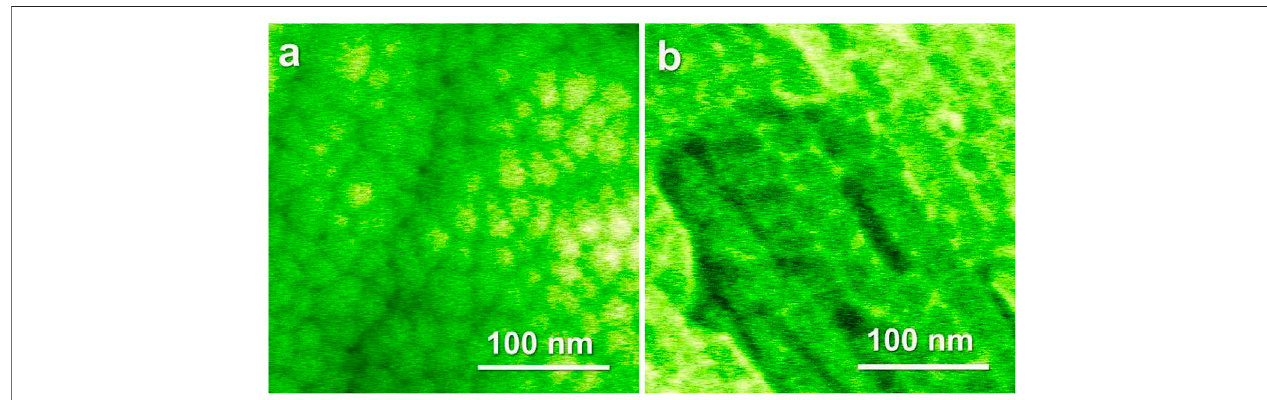
FIGURE16|(A) SEMimageoftheAu 52 Ag 5 Pd 2 Cu 25 Si 10 Al 6 nanoglasssurfacefromplanview. (B) SEMimageoftheAu 52 Ag 5 Pd 2 Cu 25 Si 10 Al 6 nanoglassfromcross section view. From Figure 16B , the average size of the nanoglobules is about 30 nm (from (Wang J. Q. et al.,